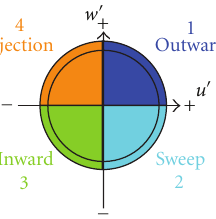
Figure 11: The scheme of event definitions used in velocity fluctuation quadrant